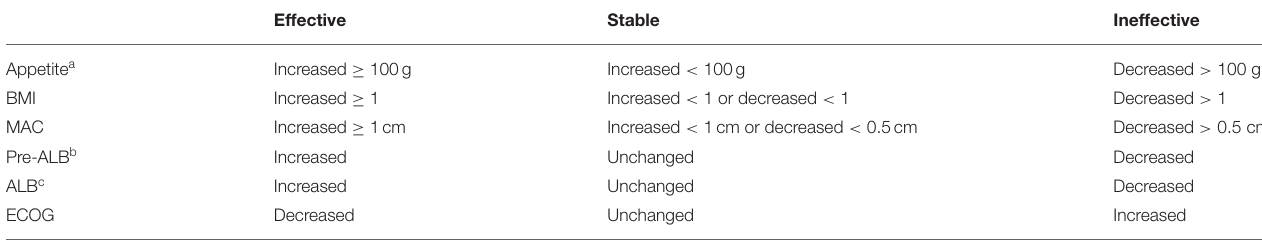
TABLE 1 | Evaluation of efficacy endpoints.